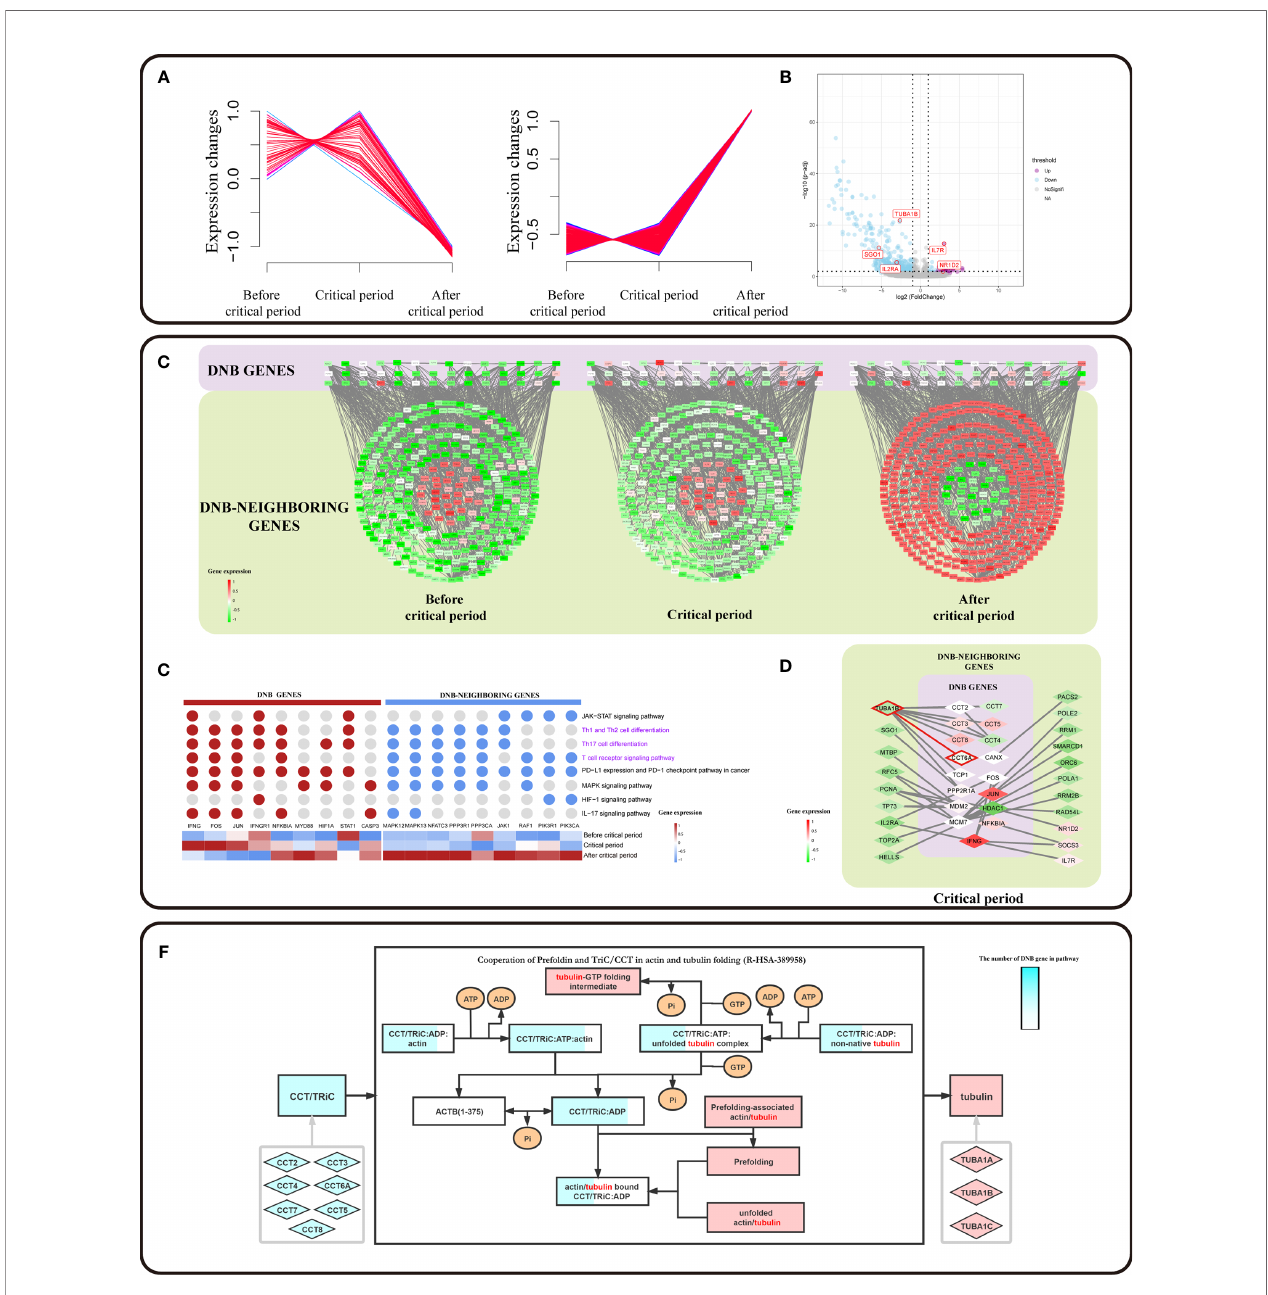
FIGURE 4 | DNB core genes drive the fl ipped expression of DNB-neighboring genes. (A) The series of diagrams illustrate the patterns of dynamic changes in DNB-neighboring genes between exhaustion critical period and terminally exhausted period using Mfuzz. The x-axis represents three T cell exhaustion periods, and the y-axis represents gene expression. The dash indicates the dynamic genes expression. (B) Volcano plot of DEGs between pre-exhausted T cell subpopulation and terminal Tex cell subpopulation. Purple dots represent differentially upregulated genes, blue dots represent differentially down regulated genes, and grey dots represent non-signi fi cant genes (p value <0.05 and |logFC|>1). (C) Cytoscape visualization of DNB genes and DNB-neighboring genes interaction network, including three T cell exhaustion periods. The network nodes arranged in squares from the purple region are DNB genes. The network nodes arranged in circles from the dark green region are DNB-neighboring genes. The genes and their location in the network are the same for all three different exhaustion states, and low to high gene expression is indicated by a gradation from green to red. (D) Genes associated with pathways located in immune-related pathways (pathways associated with T cell pathways are indicated in purple). Expression of DNB genes in the pathway indicated by a gradation from blue to red. (E) Cytoscape visualization of DNB genes and DNB neighboring-DEG interaction network in the critical state. The network nodes from the purple region are DNB genes. The network nodes from the dark green region are DNB-neighboring-DEGs. Expression of genes indicated by a gradation from green to red. (F) Reactome pathway analysis results contain Cooperation of Prefoldin and TriC/CCT in actin and tubulin folding (R-HSA-389958) in human biology. The light blue rhombus represents the CCT gene family and pink represents tubulin genes. Squares represent the biological molecule. The blue area in the square represents the number of genes in the overexpression